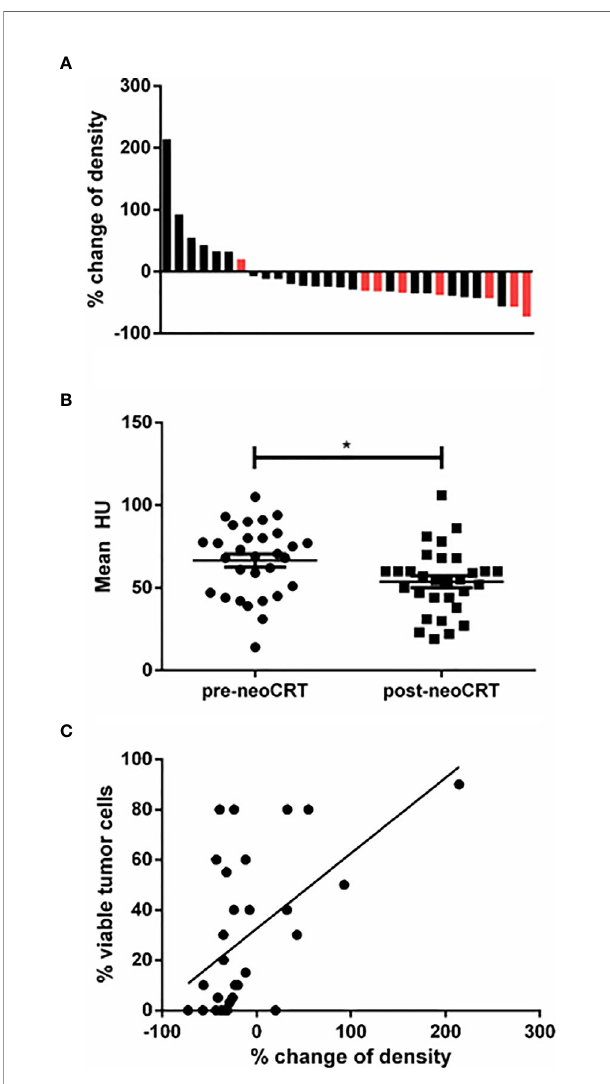
FIGURE 3 | (A) Waterfall plot of the increase and decrease of ceCT-based density. Black: patients without pCR; red: patients with pCR. Relative change is indicated as percent of the initial mean HU measured. 8 patients had increasing density and 22 had decreasing density. Greatest decrease was 72%. (B) Mean HU of all tumor samples pre- and post-neoCRT (p=0.017). (C) Correlation between viable tumor cells in the histopathologic specimen and change of ceCT based density (r²=0.30, p=0.002). * is a symbol for signi fi cant